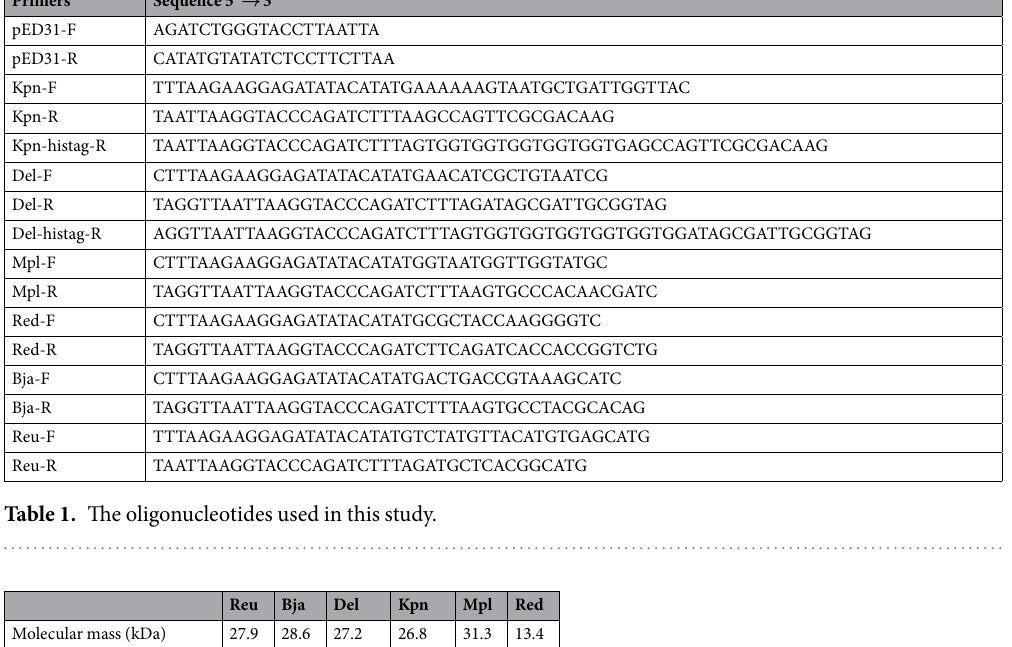
Soluble expression Y Y Y Y N N Enzyme activity (crude, amination, NADPH, U/mg) 1.2 Enzyme activity (purified, amination, U/mg) Enzyme activity (purified, deamination, U/mg) Table 2. Specific enzyme activities of recombinant AspDHs. * OAA amination activity is determined with NADH as cofactor. ** OAA amination activity is determined with NADPH as